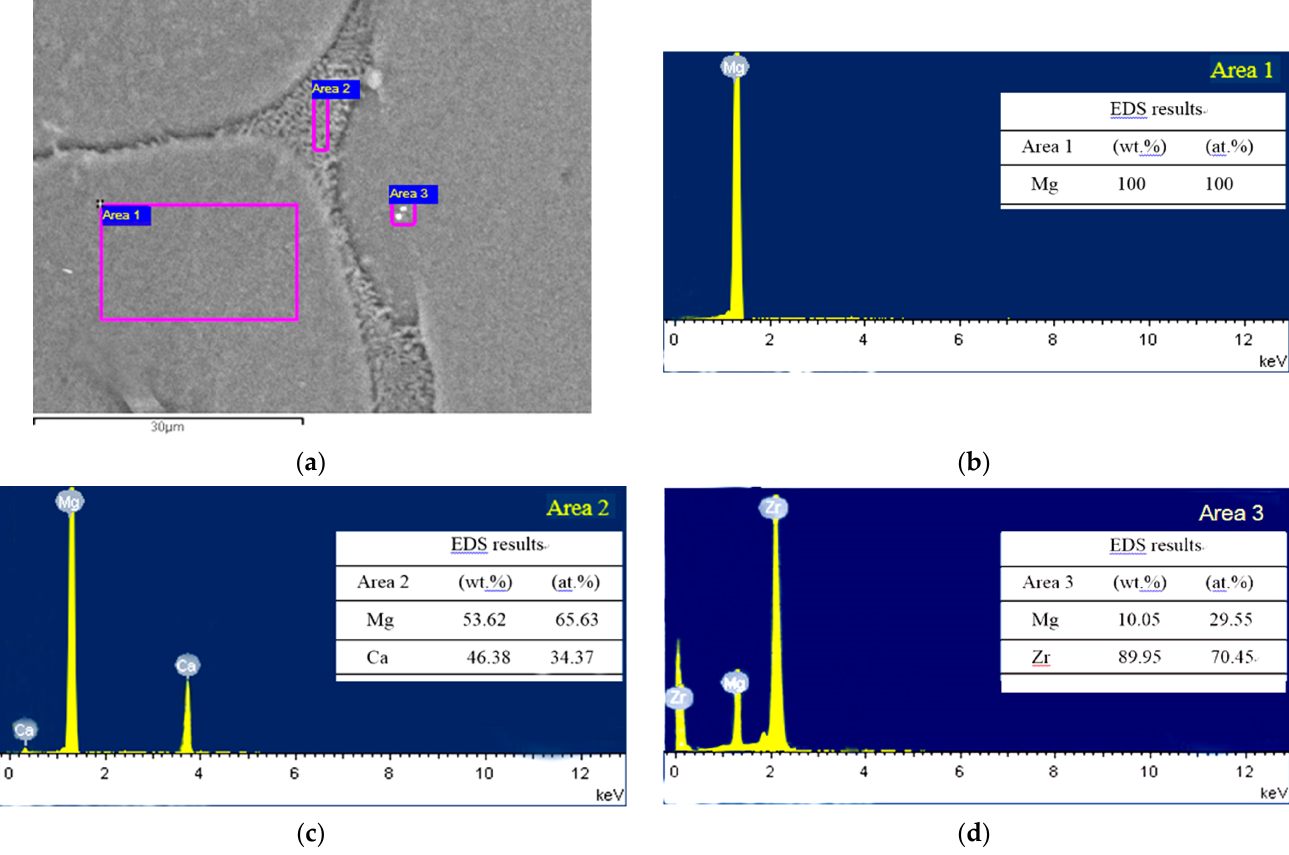
Figure 5. ( a ) SEM microstructure of as-cast Mg-0.5Ca-0.5Zr alloy, ( b ) EDS analysis of area 1, ( c ) EDS analysis of area 2 and ( d ) EDS analysis of area 3.